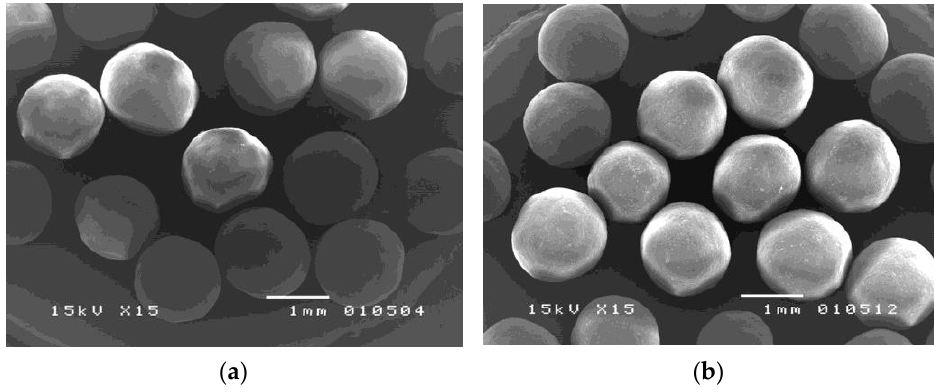
Figure 4. SEMs showing surface views at 15× magnification of ( a ) Ca/P/Ca/P-coated metoprolol tartrate pellets; ( b ) P/Ca/P/Ca-coated metoprolol tartrate pellets.